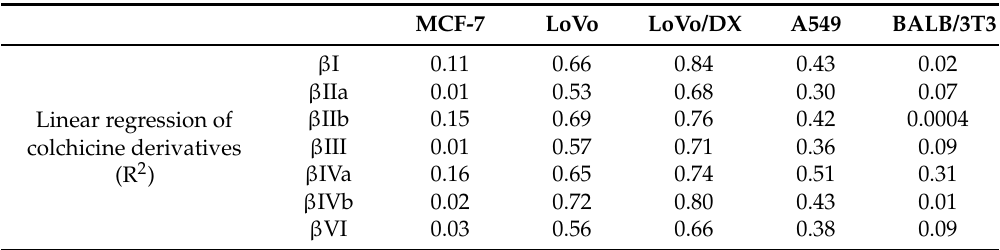
Table 3. Linear regressions involving two independent variables (the binding free energy obtained from the docking method and MlogP) of the investigated colchicine derivatives versus log IC 50 [ µ M] in different cancer cell